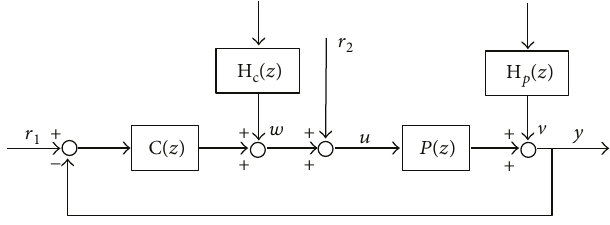
Figure 1: Schematic diagram of closed-loop